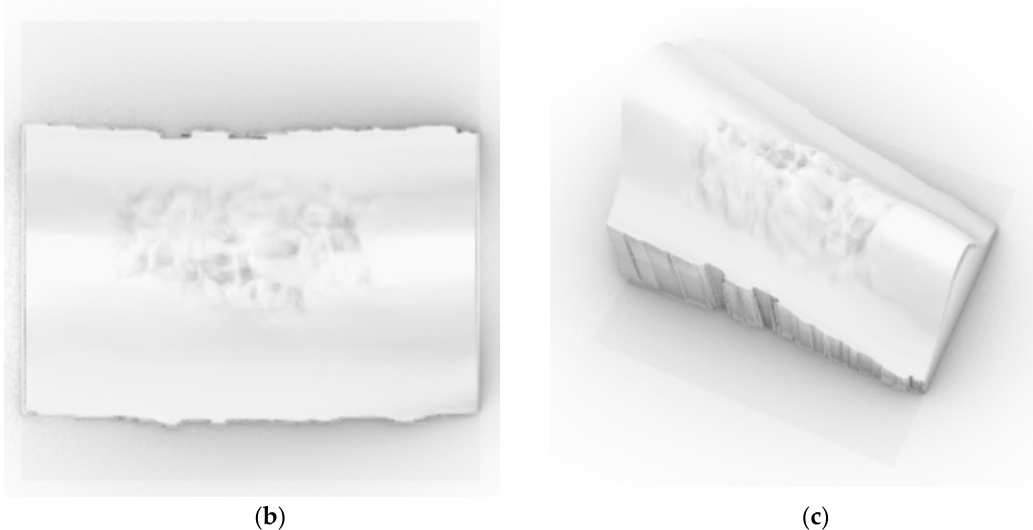
Figure 28. ( a ) Image of the rubber oxidized model; ( b ) rubber oxidized model (top view); ( c ) rubber oxidized model (perspective view).